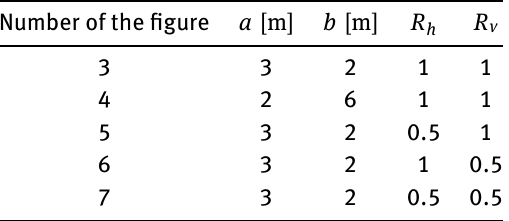
Table 1: Values of the observer position and reflection factors of the walls in Figures 3 to